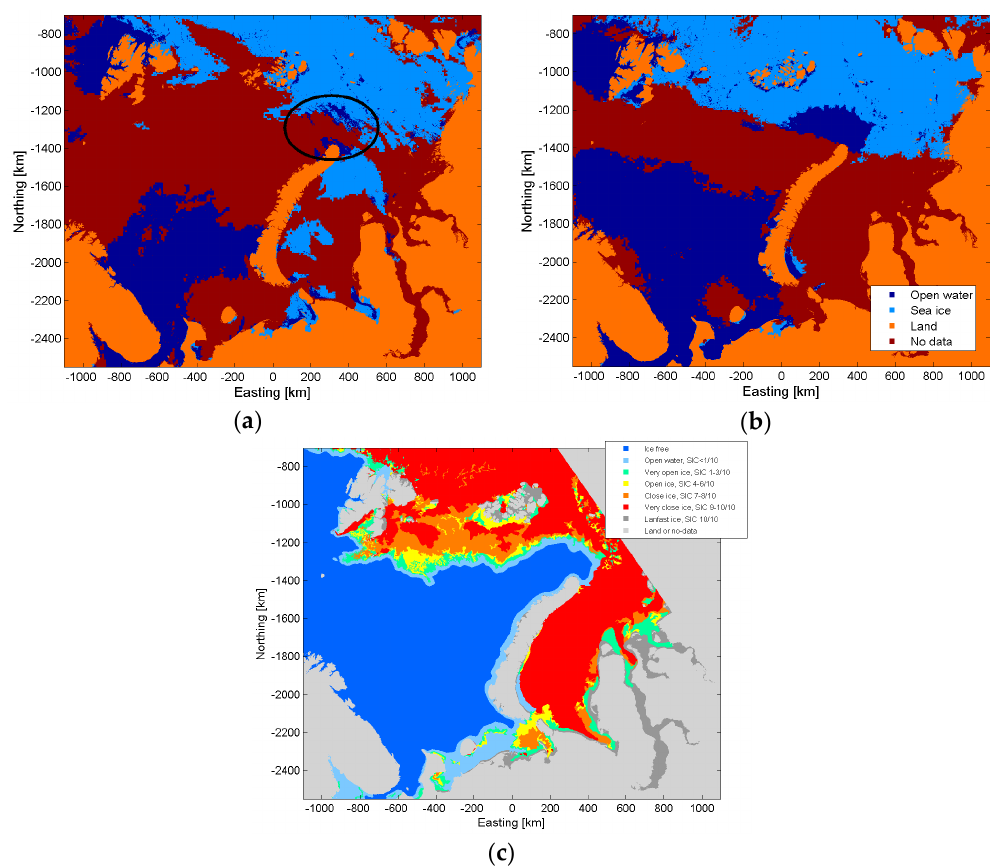
Figure 17. Daily open water–sea ice chart ( a ) on 27 April 2016 and ( b ) 28 April 2016. ( c ) METNO ice chart on 27 April 2016. An area indicated by ellipsoid in ( a ) has undetected clouds miss-classified as sea ice. The chart in ( b ) has good quality based on the visual analysis of the MODIS RGB imagery and the METNO ice chart.